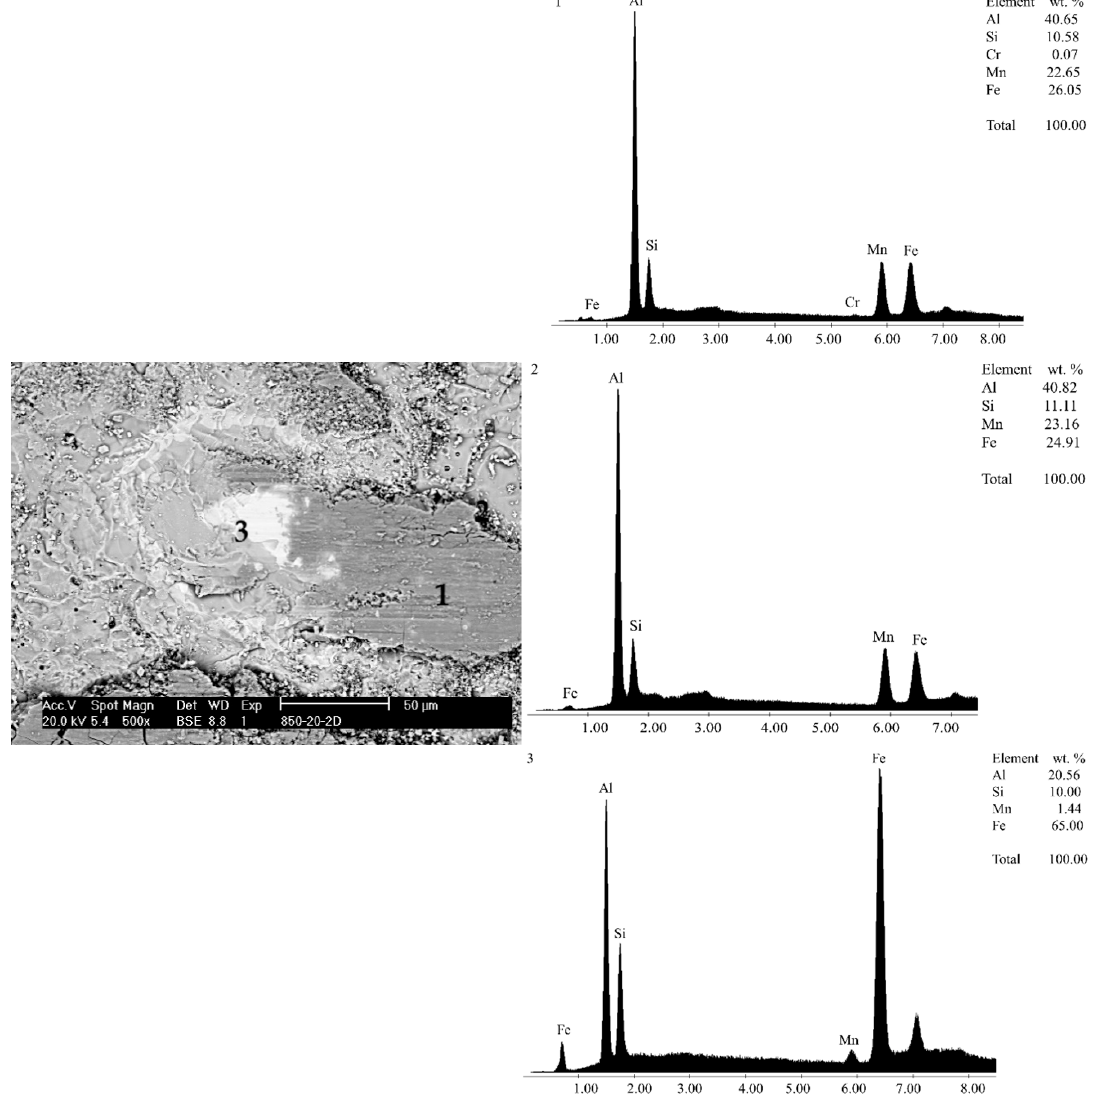
Figure 16. SEM image and corresponding EDS spectra (at the indicated zones) of the coating of a sample processed at 850 °C and 20 MPa for 7200 s after pin-on-disk wear testing.